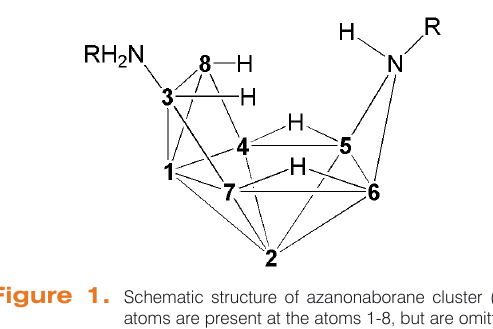
Figure 1. Schematic structure of azanonaborane cluster (exo-H atoms are present at the atoms 1-8, but are omitted for clarity). Each number corresponds to a boron